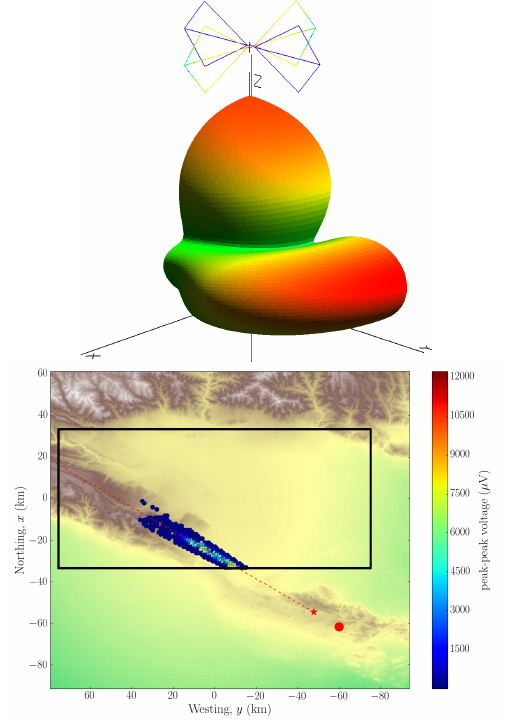
Figure 2. Top: NEC4 simulation of the HorizonAntenna gain as a function of direction. Bottom: One simulated neutrino event displayed over the ground topography of the simulated area. The large red circle shows the position of the tau production and the red star, its decay. The dotted line indicates the shower trajectory. Circles mark the positions of triggered antennas. The color code represents the peak-to-peak voltage amplitude of the antennas. The limits of the simulated detector are indicated with a black